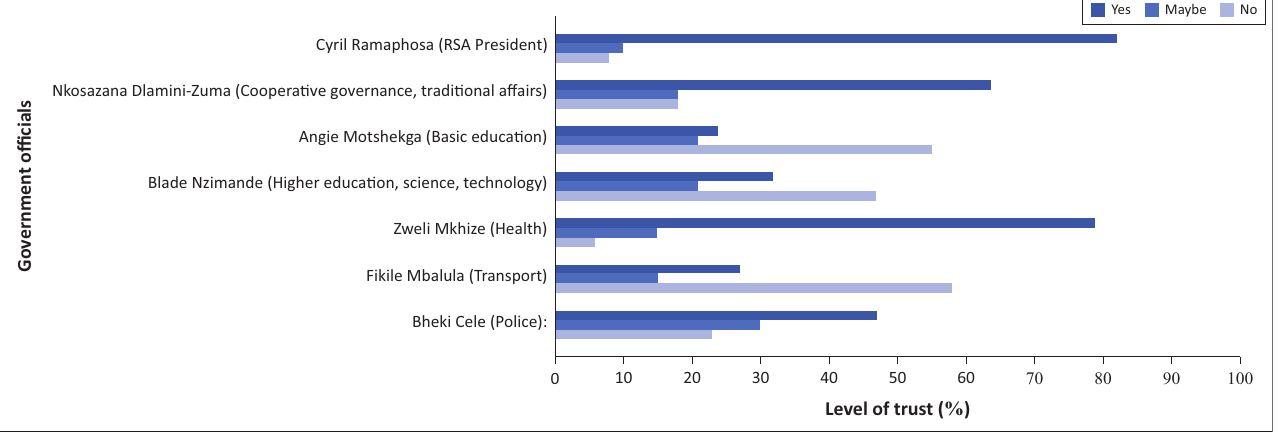
Cyril Ramaphosa (RSA President) Nkosazana Dlamini-Zuma (Coopera(cid:31)ve governance, tradi(cid:31)onal affairs) Angie Motshekga (Basic educa(cid:31)on) Blade Nzimande (Higher educa(cid:31)on, science,